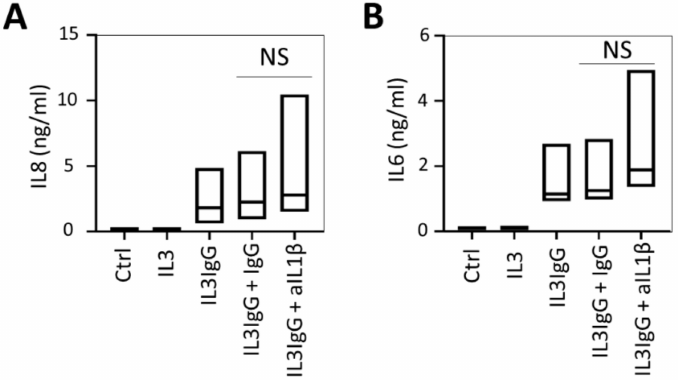
Figure 2. Release of IL6 and IL8 by human bronchial fibroblasts stimulated with products from activated eosinophils is independent of IL1 β . HBF were stimulated with eosinophil supernatants (IL3 or IL3IgG) or basal medium (Ctrl). IL3IgG eosinophil supernatants were incubated for 1 h with IgG control antibody (1 µ g/mL) or IL1 β neutralizing antibody (aIL1 β , 1 µ g/mL) prior to stimulation, as indicated. Twenty-four hours later, HBF supernatants were tested for IL8 ( A ) and IL6 ( B ) via ELISA ( n = 4 for all conditions). Paired Student’s t -test was used to test for statistically significant differences (NS = not